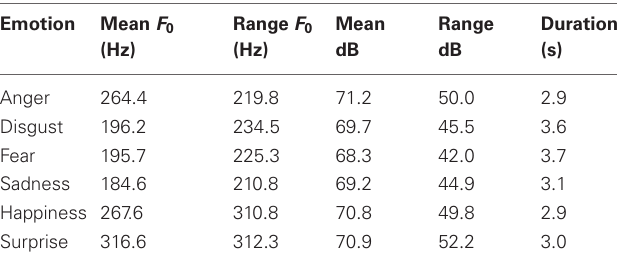
Table 1 | Acoustic measures of emotional expressions produced by both